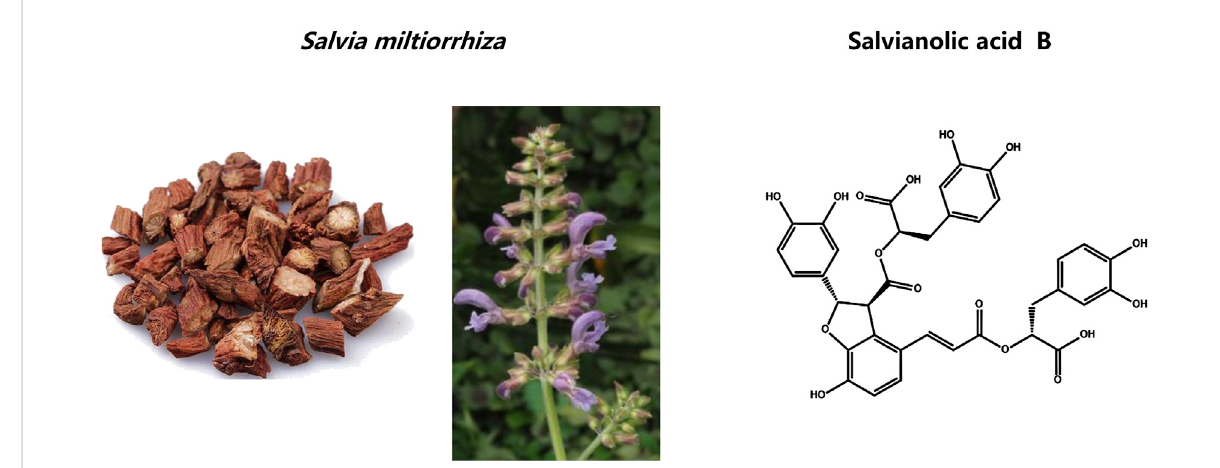
Chemical structures and natural sources of salvianolic acid B.